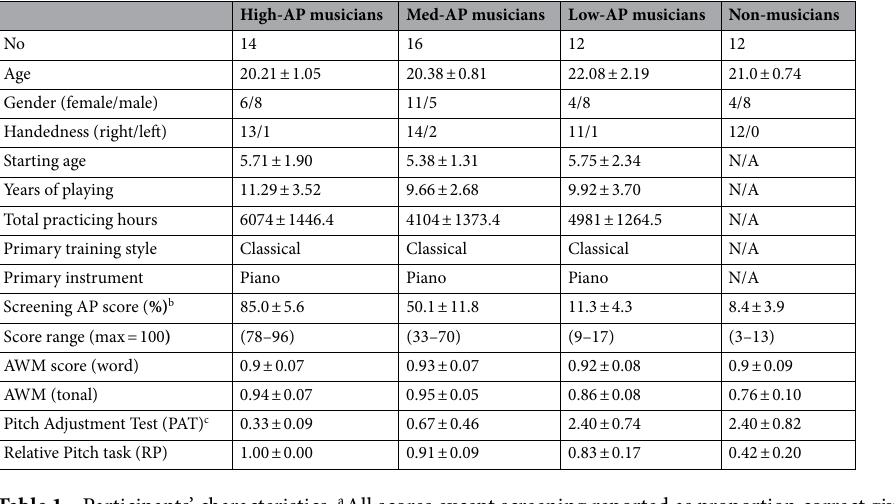
Table 1. Participants’ characteristics. a All scores except screening reported as proportion correct given as Mean ± SD. b Score given in percentage combined from pure tones and piano notes (see “Methods”). c Mean deviation in